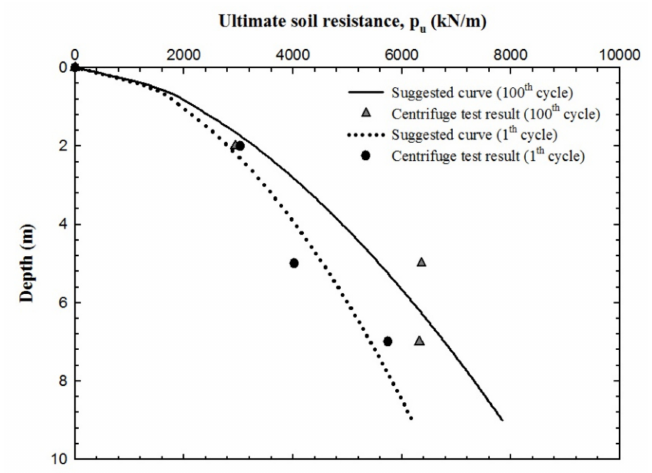
Figure 14. Ultimate soil resistance by depth at a relative density of